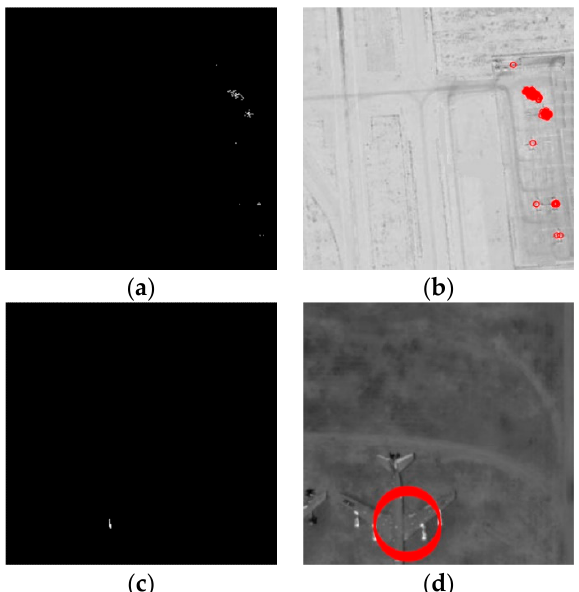
Figure 5. The result graph of proposed method. ( a , c ) Threshold segmentation map; ( b , d ) Circles with radii of the circumference centered on the points in ( a ) and ( c ) is marked on the original image.